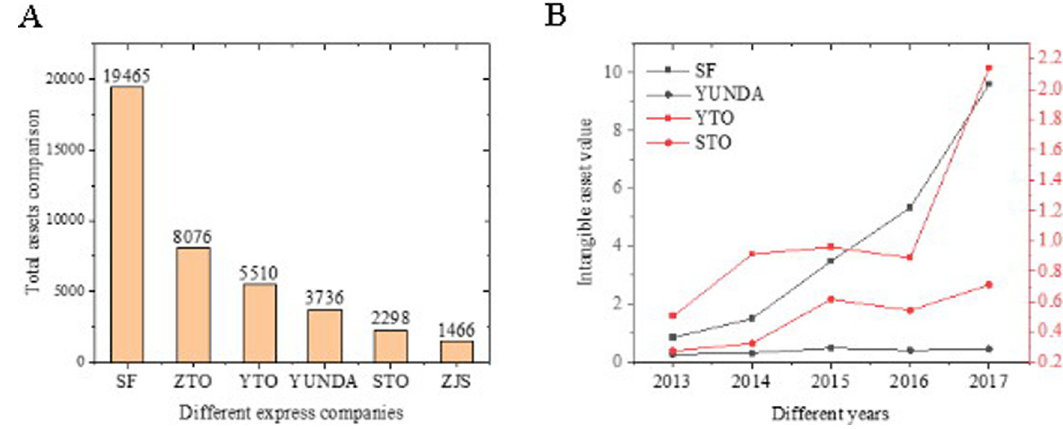
Fig 4. Comparison of the value structure of heavy assets and intangible